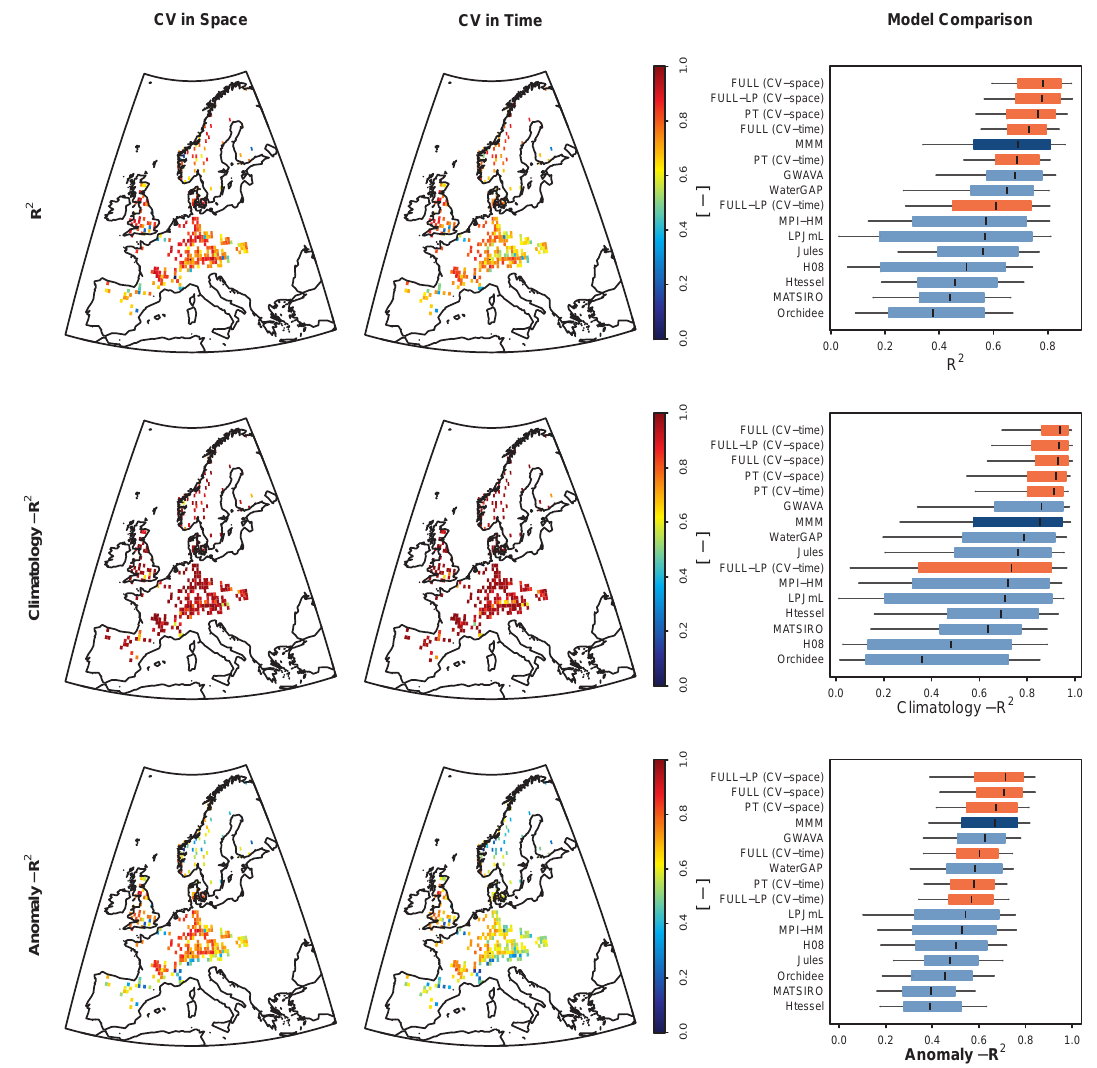
Figure 7. Grid-cell-scale validation (B): same as Fig. 6 but for different skill